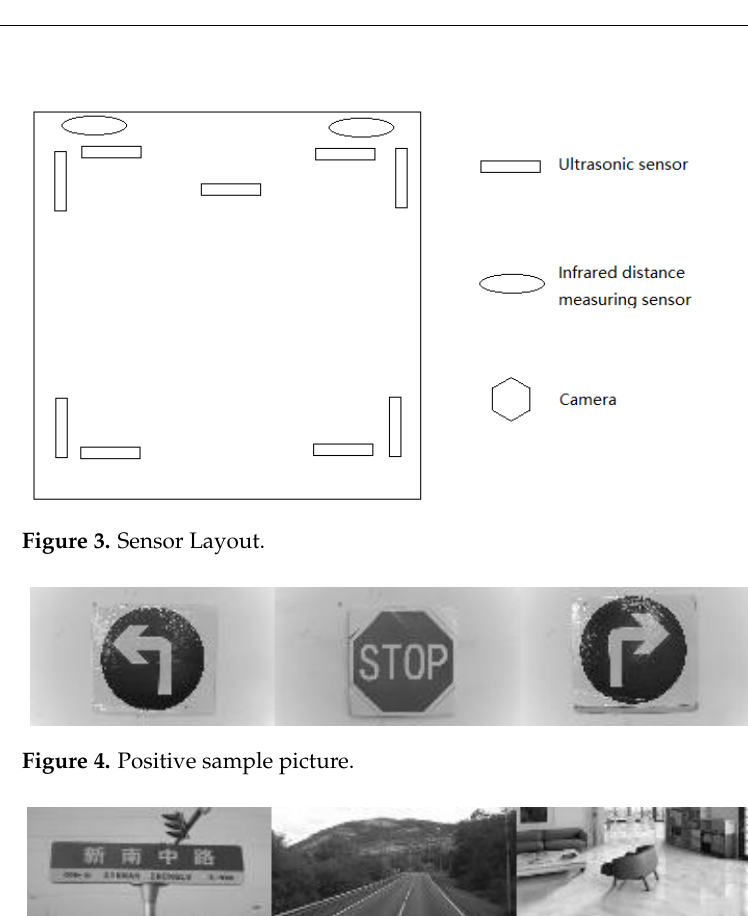
Figure 5. Negative Sample Picture.